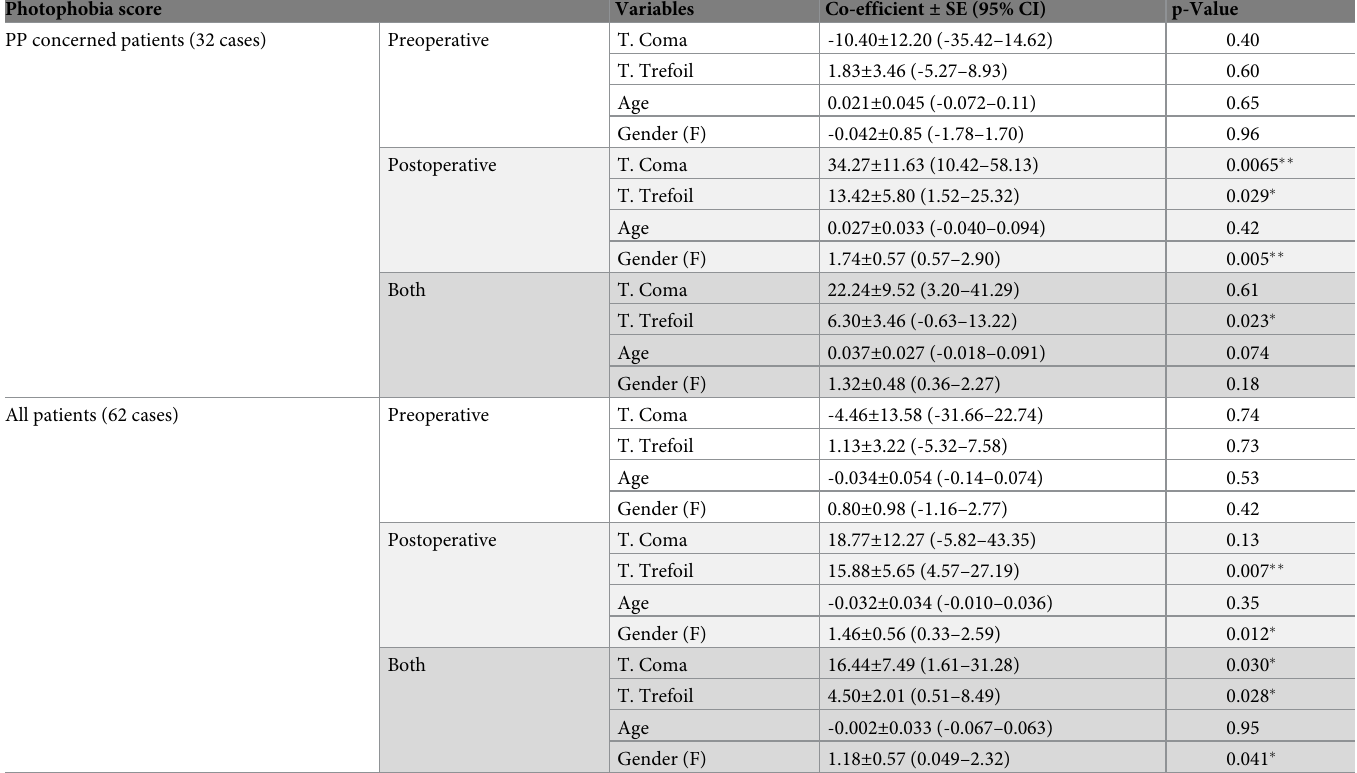
Table 4. Association between photophobia score and HOAs, age or gender with linear mixed effect